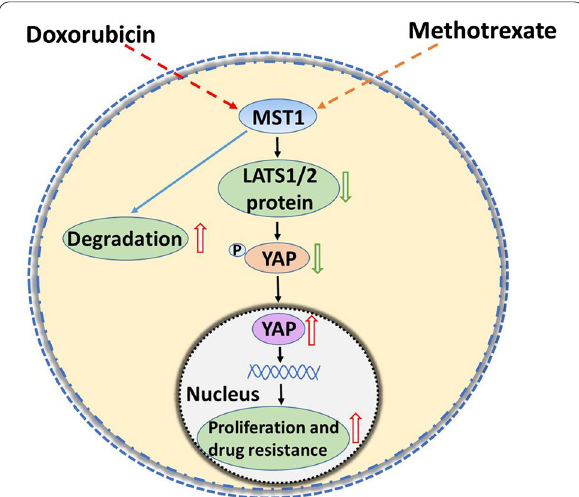
Fig. 6 Systematic model of the Hippo/YAP signaling pathway affect‑ ing cytotoxic drug resistance in osteosarcoma cells. Methotrexate and doxorubicin increase MST1 degradation in osteosarcoma cells, decreasing LATS1/2 total protein level and YAP phosphorylation, resulting in enhanced nuclear translocation of YAP. Endonuclear YAP then promotes the transcription of its downstream targets involved in anti‑apoptosis and proliferation, leading to elevated proliferation and resistance to methotrexate and